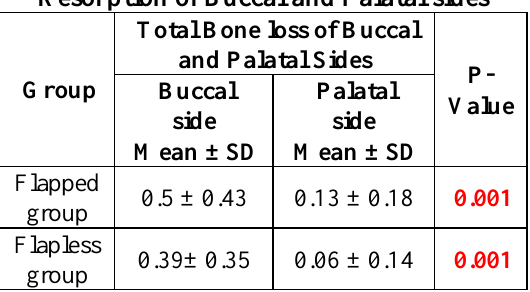
Table 2: Comparison between